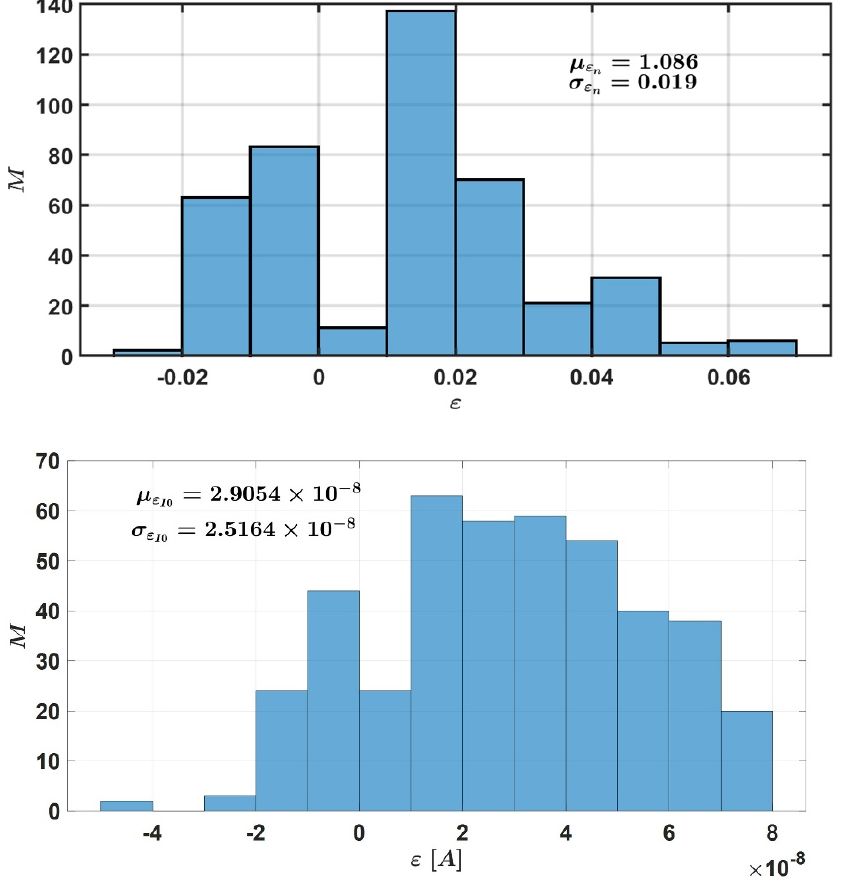
Figure 19. Estimation of the SDM parameters.